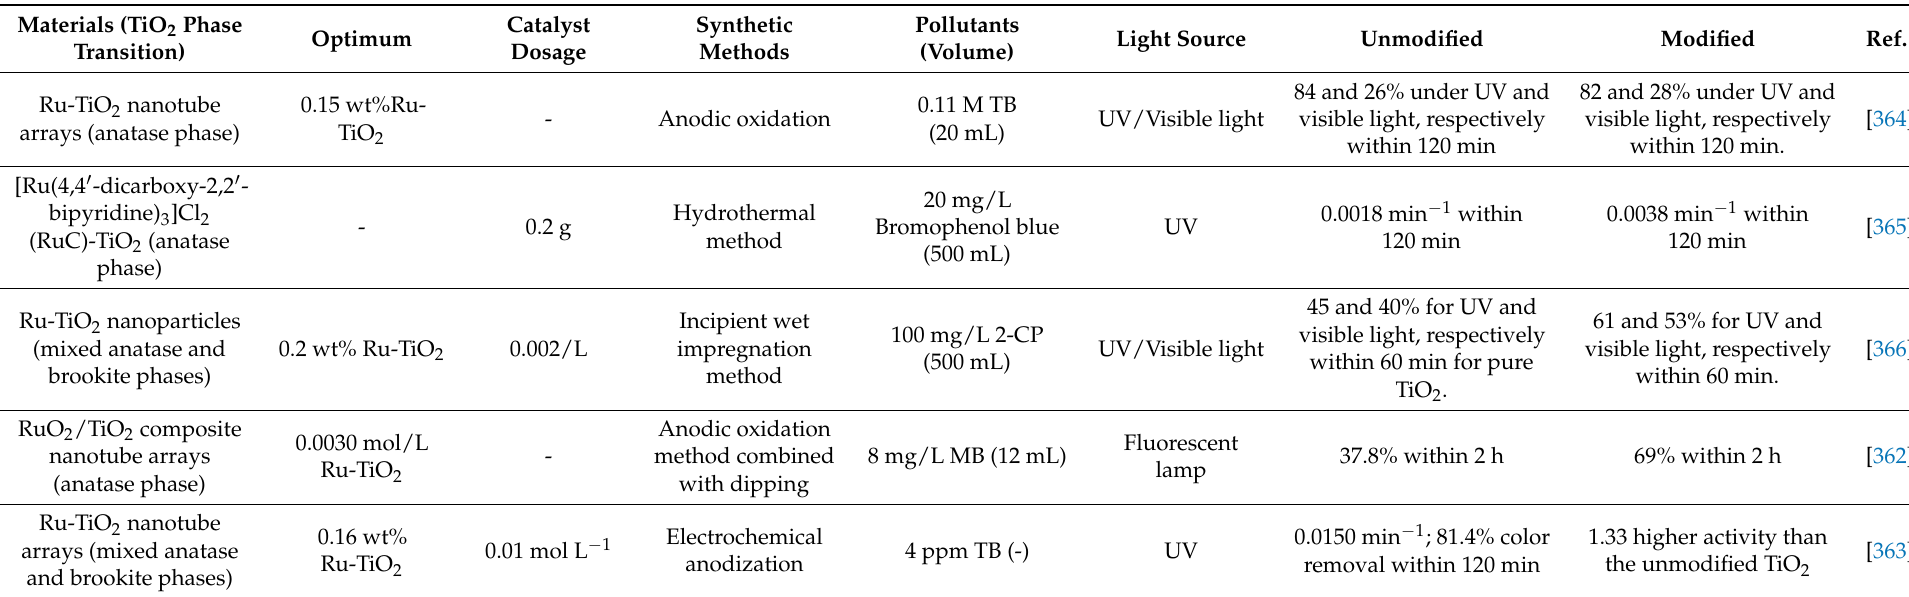
Table 18. Summary of recent progress on Ru-TiO 2 photocatalysts for organic pollutants